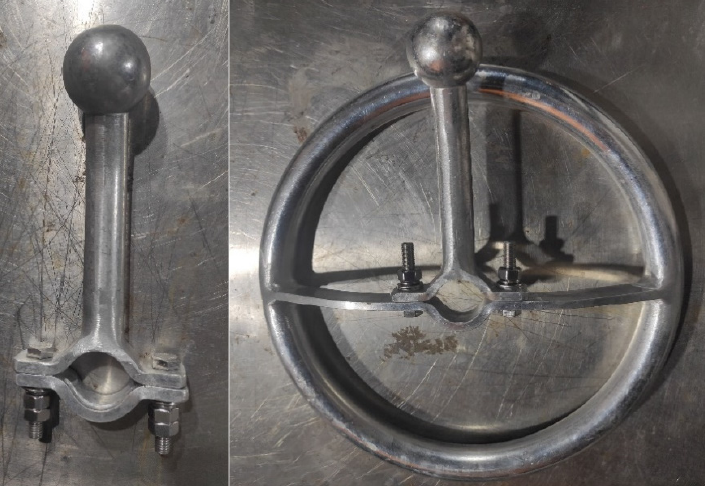
Figure 8. Ring parallel gap of